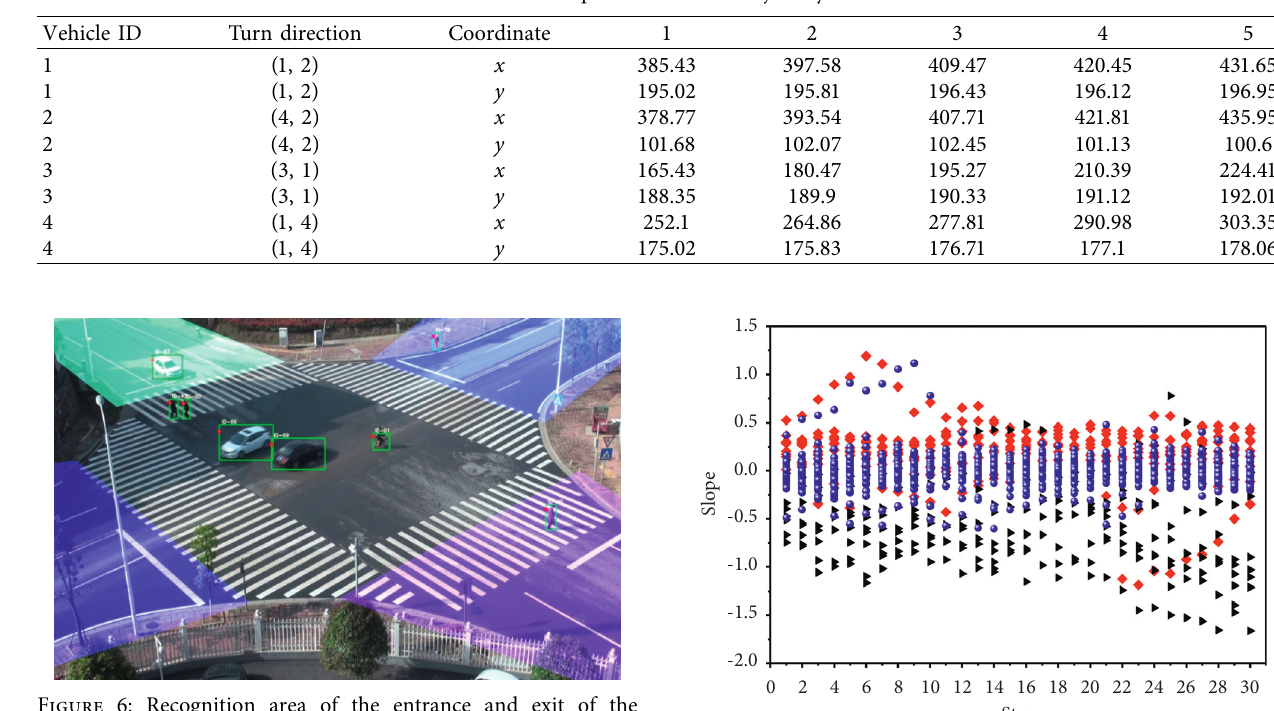
Table 1: Examples of extracted trajectory data.